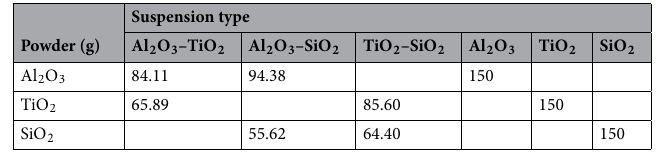
Table 1. Powder mass (g) on a per suspension basis.